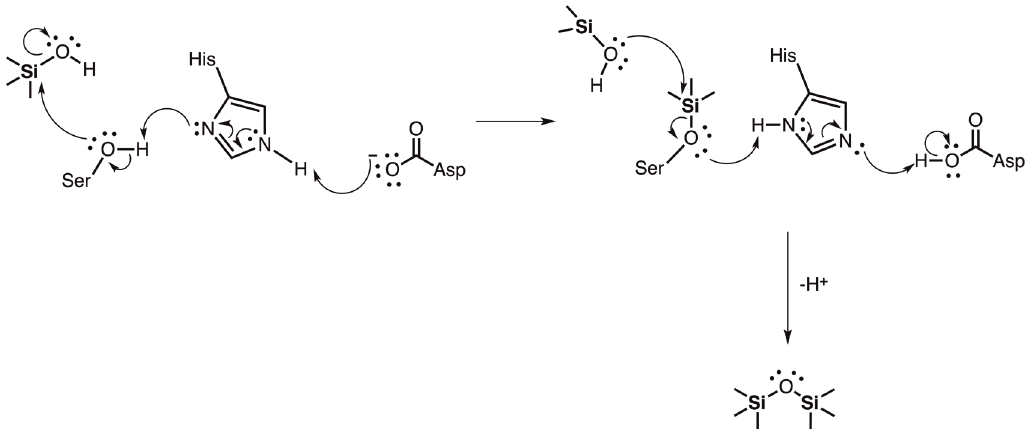
Figure 58 - A proposed mechanism for hydrolase-catalyzed silanol condensation.